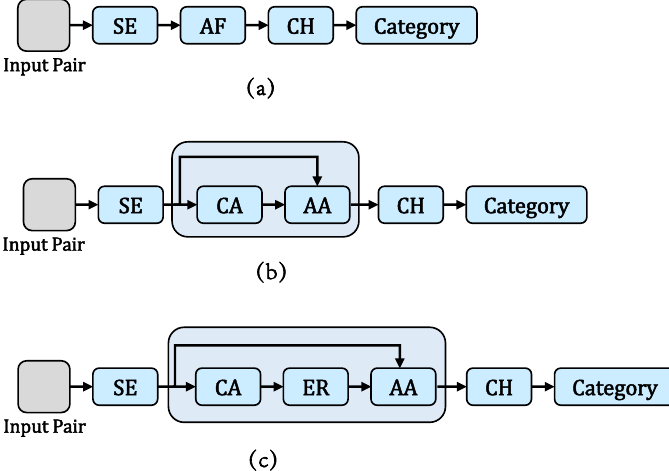
Figure 9. Different network architectures are used to investigate the role of proposed CA, AA, and introduced ER blocks for emotional state prediction. ( a , b ) denote the network without the CA, ER and AA blocks and the CAHFW-Net without the ER block, respectively, while ( c ) denotes the complete CAHFW-Net.